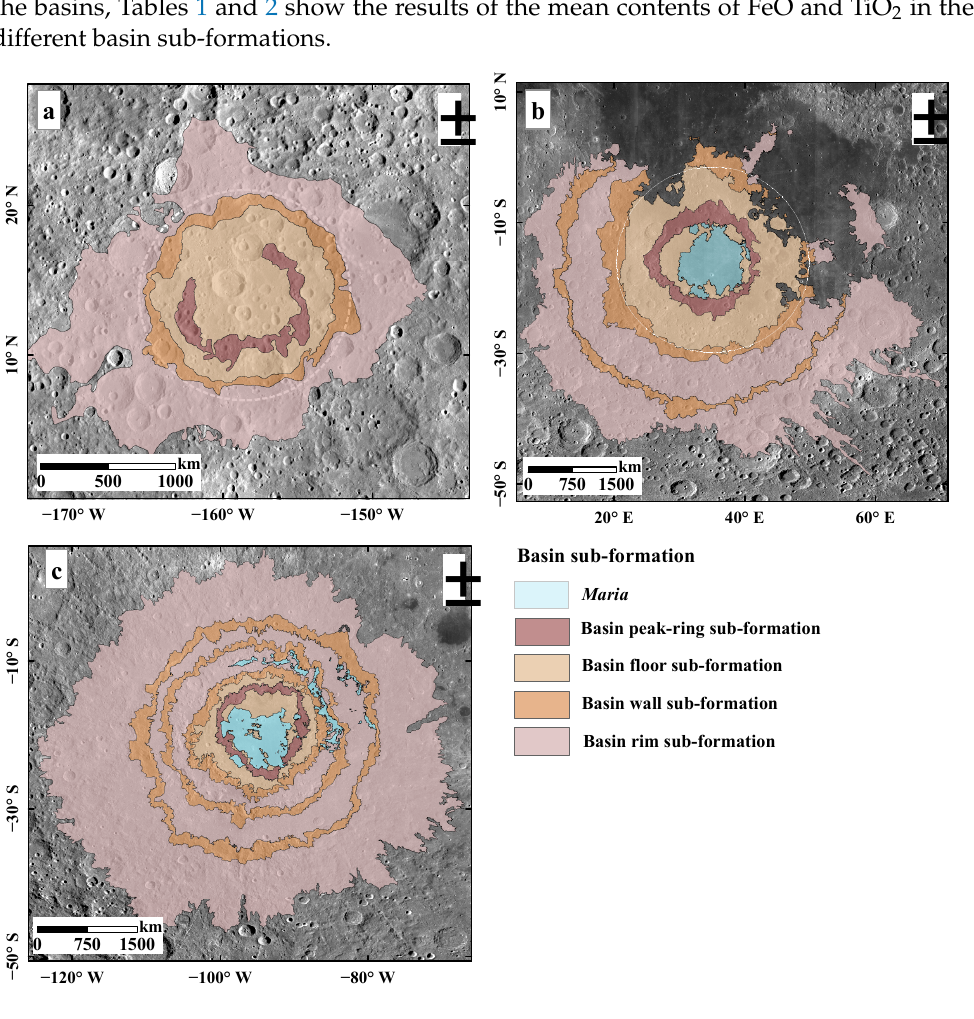
Figure 10. The landforms of the Dirichlet–Jackson Basin ( a ), the Nectaris Basin ( b ) and the Orientale Basin ( c ) (modified from Liu et al. [44] ).